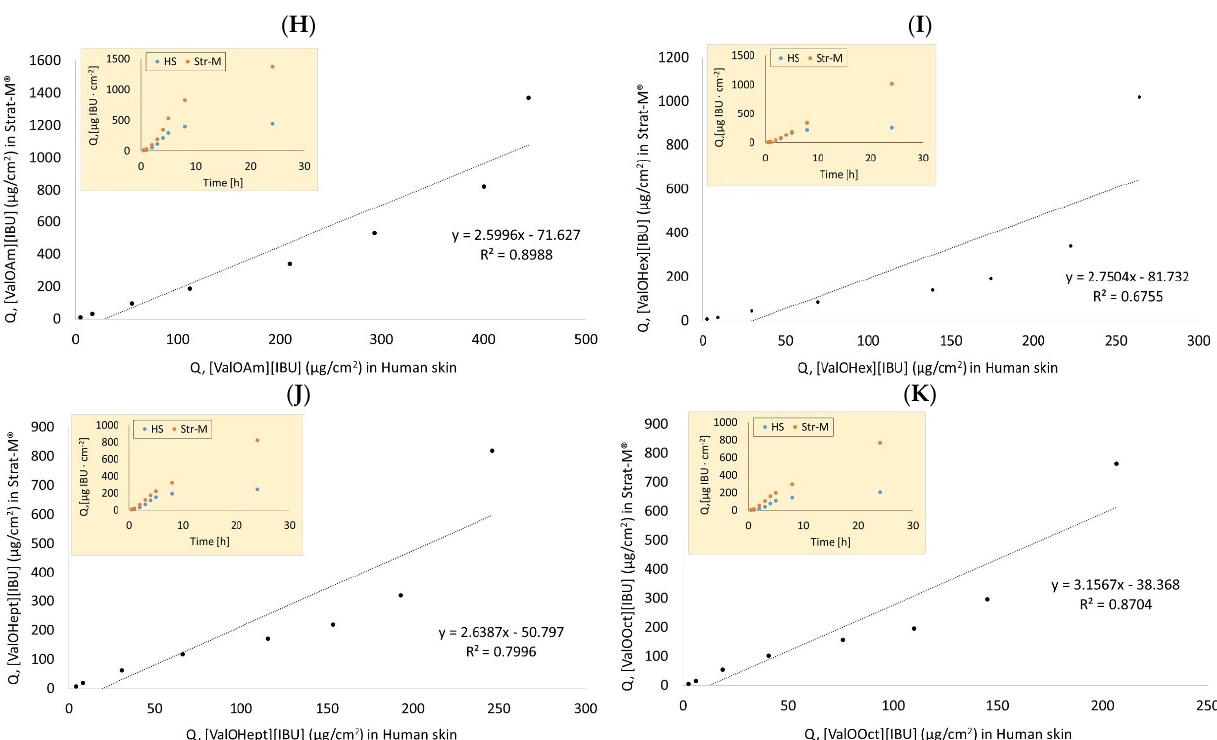
Figure 6. Comparison of mean cumulative mass during 24 h penetration and correlation between human skin and Strat-M™ for all tested formulations: ( A ) commercial product, ( B ) [IBU], ( C ) [ValOMe][IBU], ( D ) [ValOEt][IBU], ( E ) [ValOPr][IBU], ( F ) [ValOiPr][IBU], ( G ) [ValOBu][IBU], ( H ) [ValOAm][IBU], ( I ) [ValOHex][IBU], ( J ) [ValOHept][IBU], ( K ) [ValOOct][IBU]; Pearson’s test, p < 0.05.